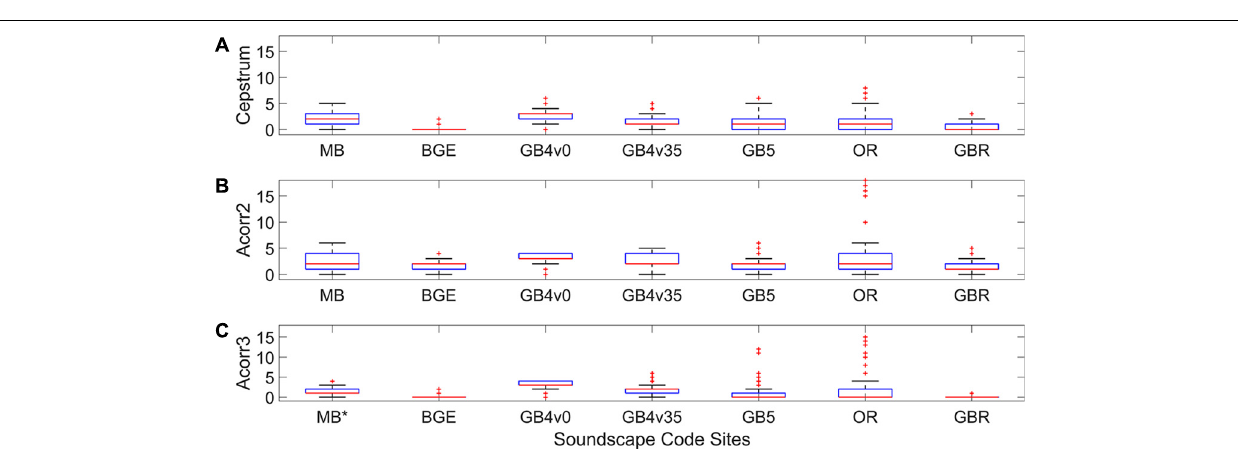
FIGURE 6 | Broadband periodicity candidate metric results for all soundscape code datasets. Values represent peaks-per-minute as reported by (A) cepstrum, (B) acorr2, and (C) acorr3. The red horizontal line indicates the median value, outer edges of boxes represent 25 th and 75 th percentiles, whiskers mark the boundary that contains approximately 99% of data values, and the red points are